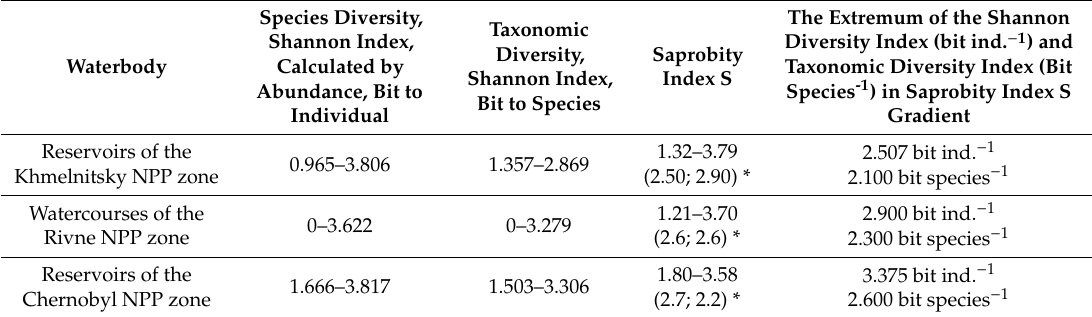
Table 3. Indicators of diversity and saprobity in zoobenthos communities of various water bodies of Ukraine (according to [42]).